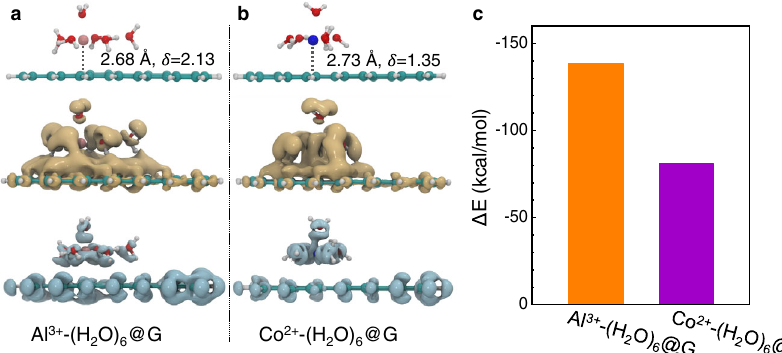
Fig. 5 | Theoretical computations for ions on graphene. The most stable opti- mized geometries and electron density differences of X@G complexes: a X is Al 3+ - (H 2 O) 6 , b X is Co 2+ -(H 2 O) 6 . Spheres in green, white, and red represent carbon, hydrogen, and oxygen atoms, respectively. Pink and blue spheres represent Al 3+